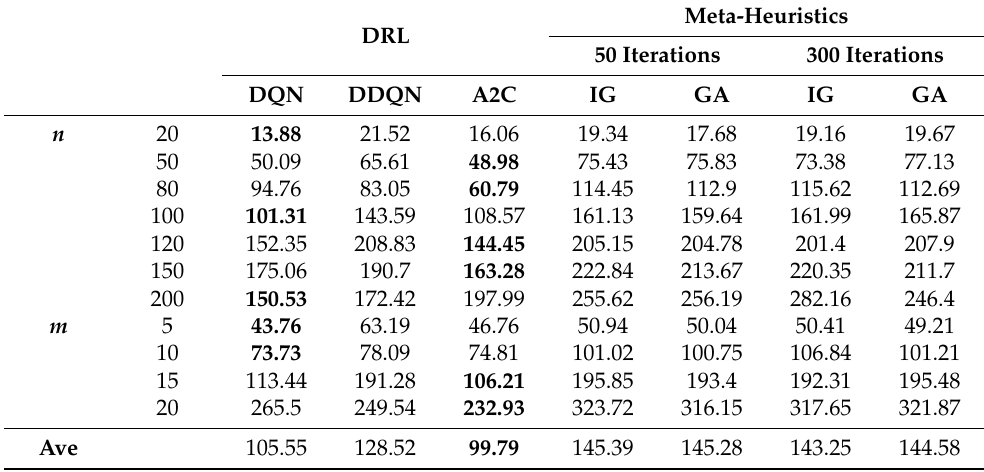
Table 3. Average total tardiness cost grouped by the number of jobs n and machines m for compared DRL and meta-heuristics. IG and GA are tested under two search iteration levels, i.e., 50 iterations and 300 iterations. The best results are highlighted in bold.